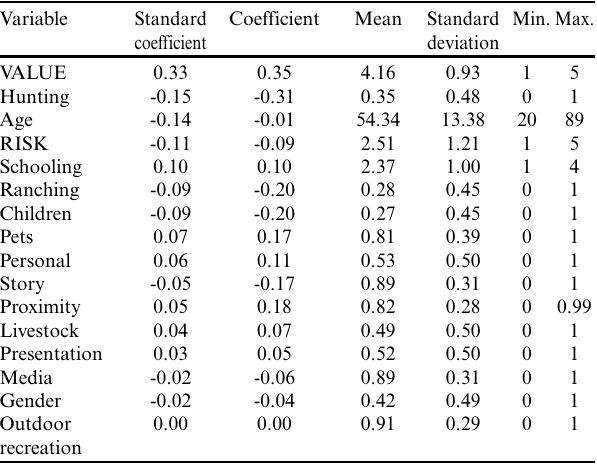
Table 3 . Descriptive statistics and ordered generalized linear regression results for the top model predicting tolerance for cougars in Clearwater County,